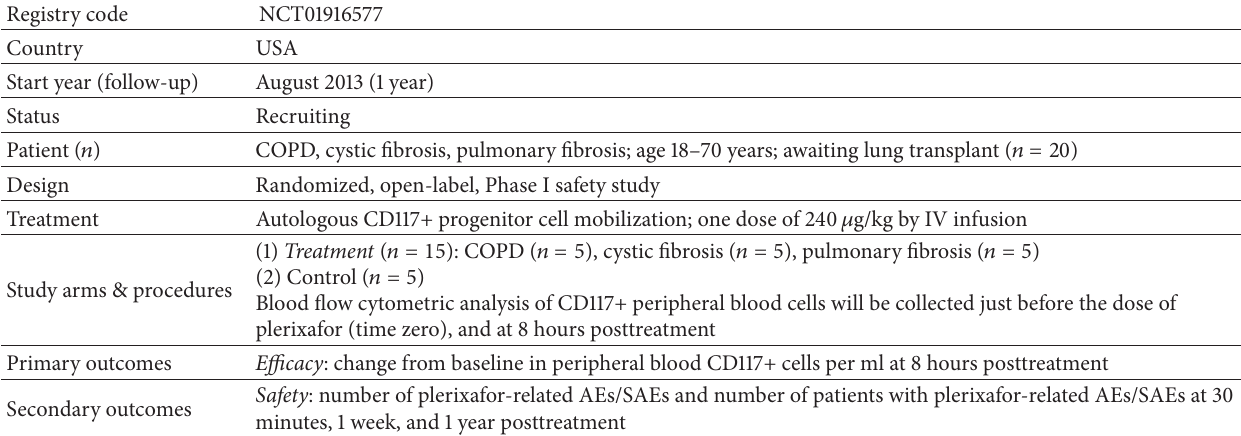
Table 6: Ongoing clinical trial of plerixafor mobilization of stem cells for COPD